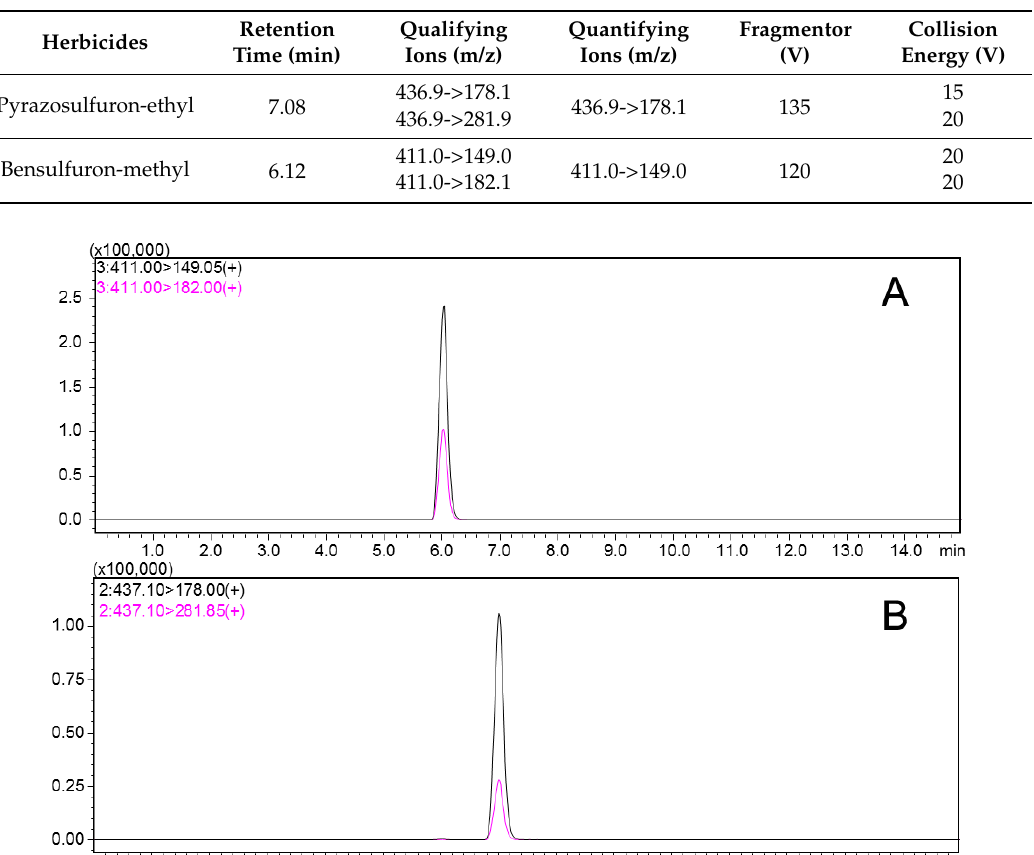
Table 2. Liquid chromatography-tandem mass spectrometry (LC–MS/MS) parameters of pyrazosulfuron-ethyl and bensulfuron-methyl.